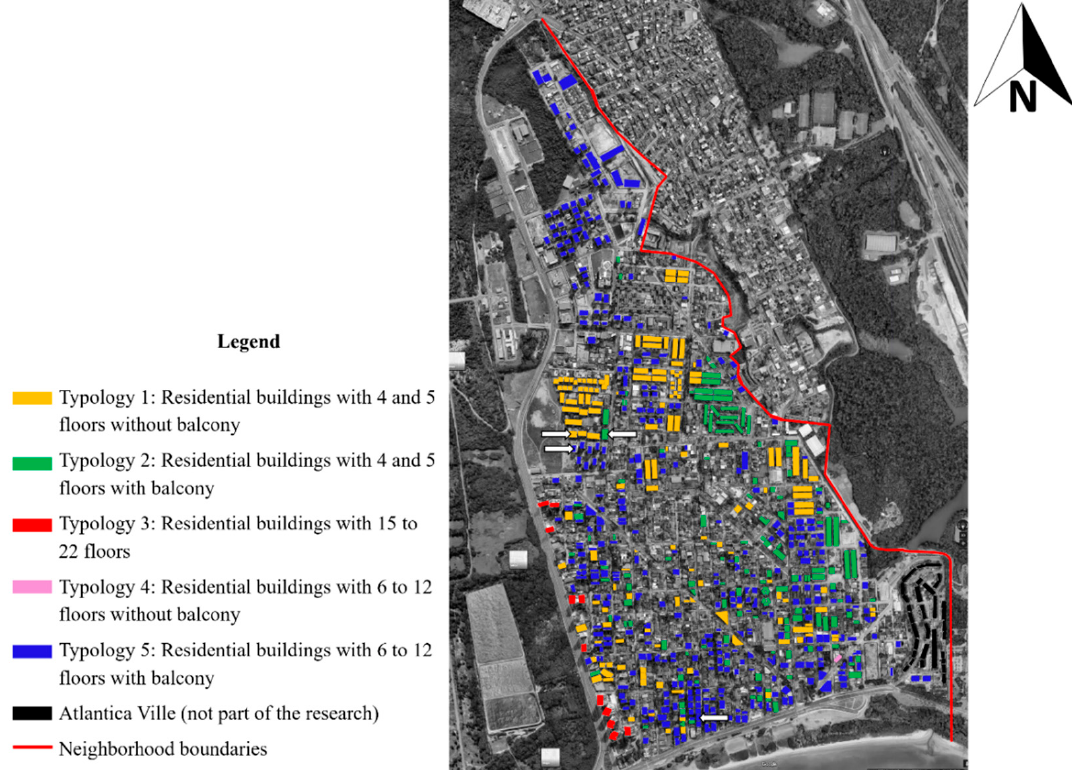
In Figure 3, the white arrows indicate the location of the representative buildings: Upper left: Building A; upper right: B; lower left: C; and lower right: D. Appl. Sci. 2019 , 9 , 3832